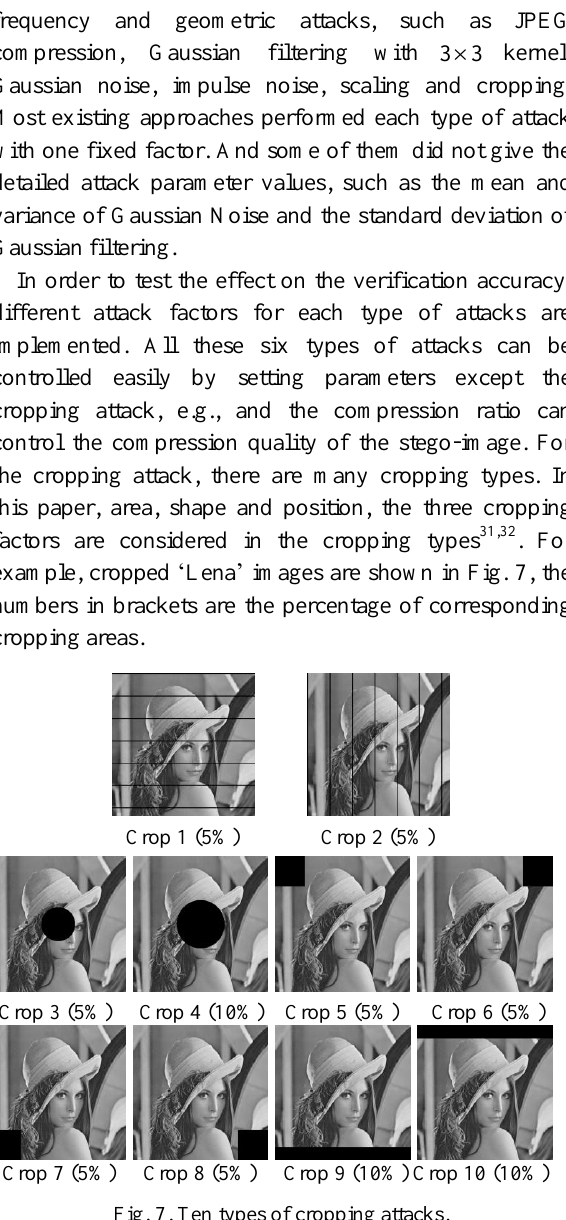
Fig. 7. Ten types of cropping